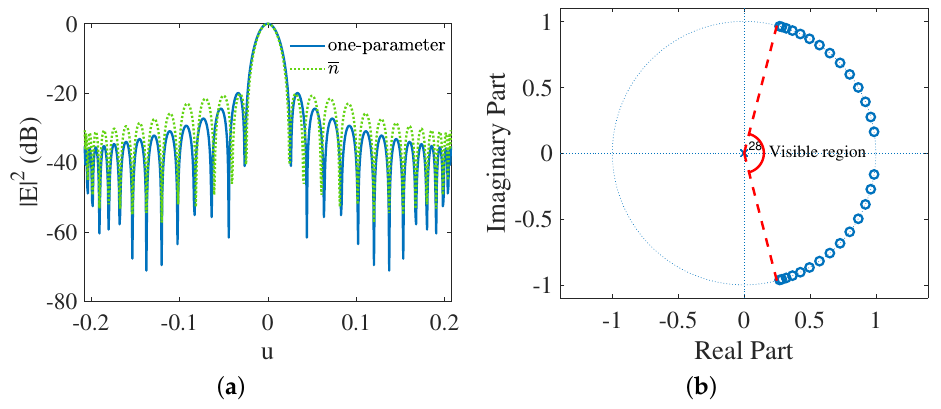
Figure 7. ( a ) Simulated 29-element one-parameter (blue line) and n (green dotted line) Taylor-like super-directive patterns. ( b ) The zeros distribution of the one-parameter Taylor-like super-directive pattern on the complex unit